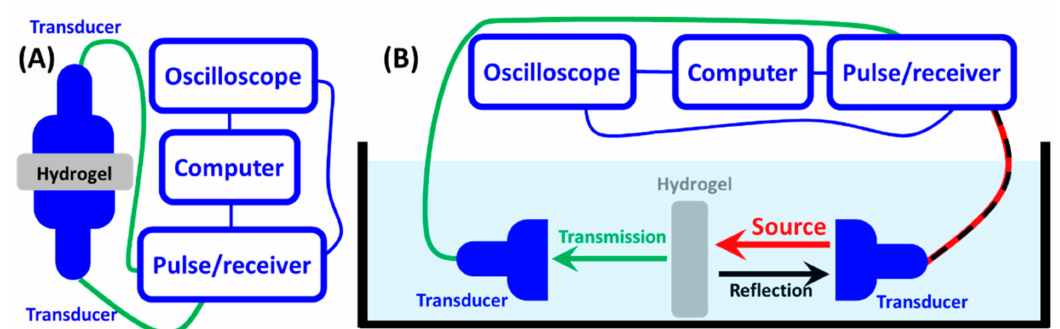
Figure 6. ( A ) Bistatic speed of sound experimental measurement for determining the temperature-dependent acoustic impedance of the hydrogel. ( B ) Temperature-dependent bistatic transmission and reflection experiments of hydrogel in